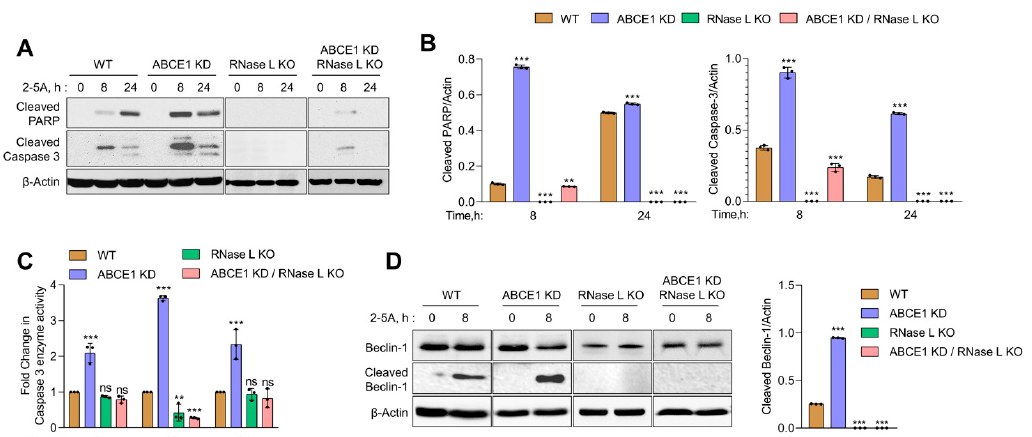
Figure 4. Increased caspase-3 activity and the proteolytic cleavage of Beclin-1 in ABCE1 knockdown cells on RNase L activation by 2-5A. ( A ) Immunoblot analysis of HT1080 WT, ABCE1 KD, RNase L KO, and ABCE1 KD/RNase L KO cells transfected with 10 μ M of 2-5A for indicated times and probed with cleaved PARP and cleaved caspase-3 antibodies and normalized to β -actin levels. ( B ) The band intensity was calculated using Image J software and the ratio of cleaved PARP/ β -actin or cleaved caspase-3/ β -actin was determined and the levels were compared to WT cells. ( C ) Caspase-3/7 enzyme activity was measured in HT1080 WT, ABCE1 KD, RNase L KO, and ABCE1 KD/RNase L KO cells transfected with 10 µ M of 2-5A for indicated times and the cleavage of fluorescent caspase-3 substrate was determined. Results shown represent mean ± SD for the experiment performed in triplicate and representative of three independent experiments. ( D ) Immunoblot analysis of HT1080 WT, ABCE1 KD, RNase L KO, and ABCE1 KD/RNase L KO cells transfected with 10 µ M of 2-5A for indicated times and probed with Beclin-1 antibodies and normalized to β -actin levels. The band intensity was calculated using Image J software and the ratio of cleaved Beclin-1/ β -actin was determined and the levels were compared to WT cells. Results are representative of three independent experiments. WT: wild-type; ** p < 0.01; *** p < 0.001; ns: not